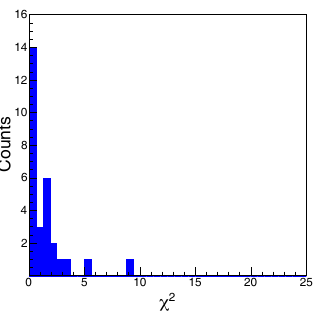
Figure 3. Preliminary χ 2 distribution for the comparison of FPYs from 240 Pu( γ ,f) at E γ = 11 . 2 MeV and 239 Pu(n,f) at E n = 4 . 6